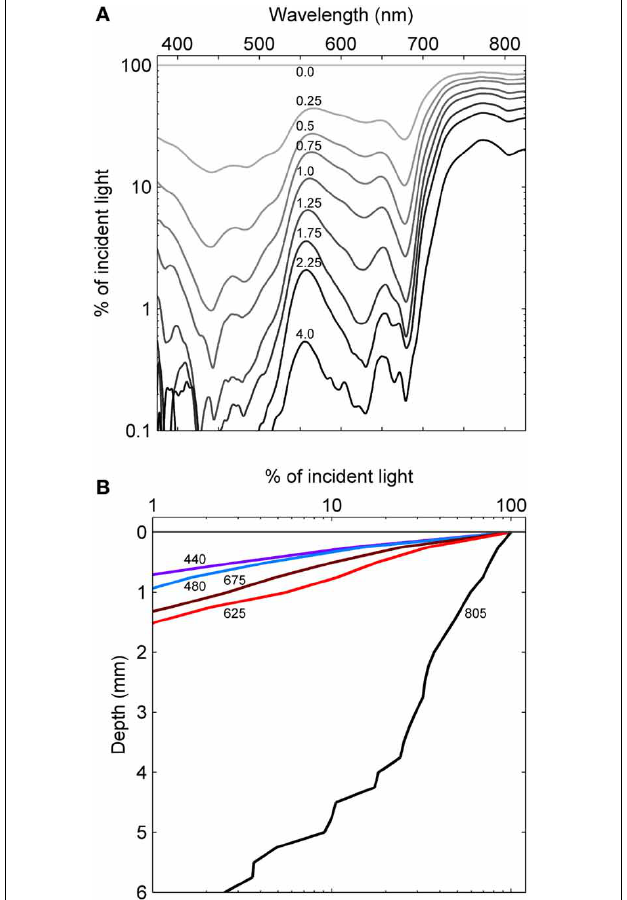
FIGURE 4 | Light penetration into the Hot Lake mat. (A) Spectrally-resolved transmission of light through the mat as measured by fiber-optic microprobe. Numbers above the curve represent the depth the probe was inserted into the mat in millimeters. (B) Attenuation of wavelengths representing local maxima in absorbance. Values denote wavelength in